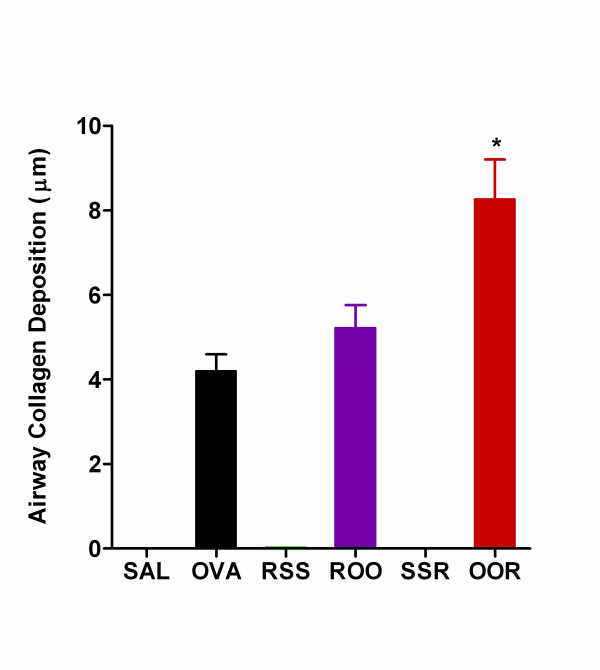
Airway remodelling is evident in weanling mice exposed to Ova and RSV. Fibrosis and deposition of collagen was observed in the subepithelial, reticular layer of the airways in the OVA, ROO, and OOR mice. Morphometric analyses using data collected at 50 μm intervals over the entire basement membrane revealed that these differences were significant. (8–10 measurements at ~50 μm intervals were collected for at least 5 airways; n = 4 mice per group). ROO vs. OOR, *p < 0.05 and OVA vs. OOR, *p < 0.01.